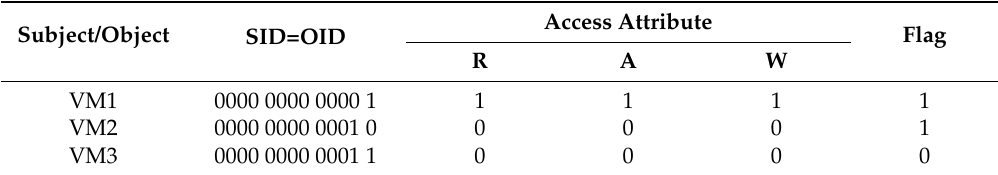
Table 6. Access matrix of VM1, VM2, and VM3.